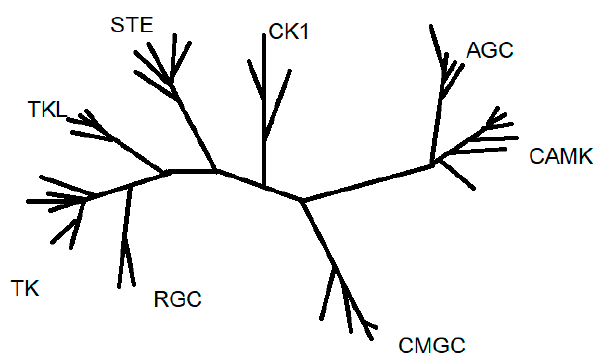
Figure 1. Proposed phylogeny general outline for the kinase superfamily [5]. The phylogenetic tree of human kinome, depicts the relationship between different members of protein kinase-superfamily based on homologies in their catalytic domains.